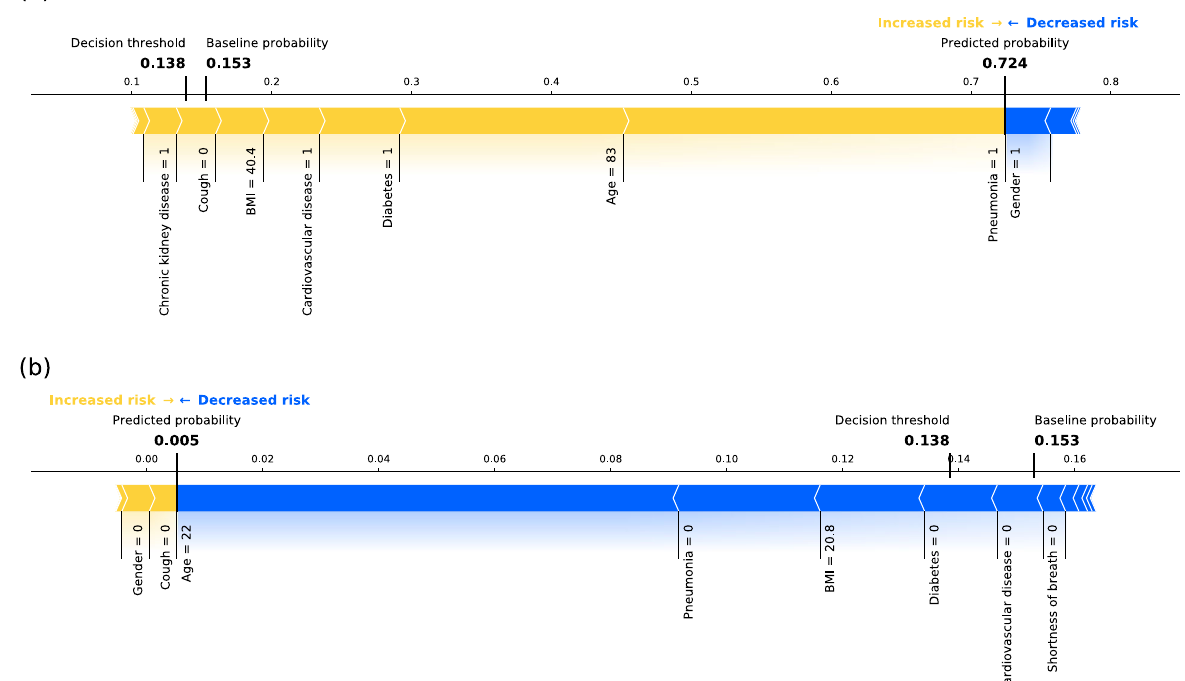
Fig. 8 Example predictions using the fi nal model. Composition of predictions (SHAP values computed in probability space) for a one example patient going into critical state and b one patient not entering critical state, based on the fi nal model. The yellow arrows represent the contributions of major risk factors (e.g., older age, pneumonia, or comorbidities), and the blue arrows represent the contribution of factors decreasing the probability of entering critical state (e.g., female gender = 1). Note that this graphical representation only allows due to spatial constraints to display the names of the major contributing factors for this speci fi c example (i.e., a subset of all features used by fi nal model). The baseline probability and the decision threshold are relatively low but close to the actual ratio of patients entering critical state in our cohort, illustrating the class